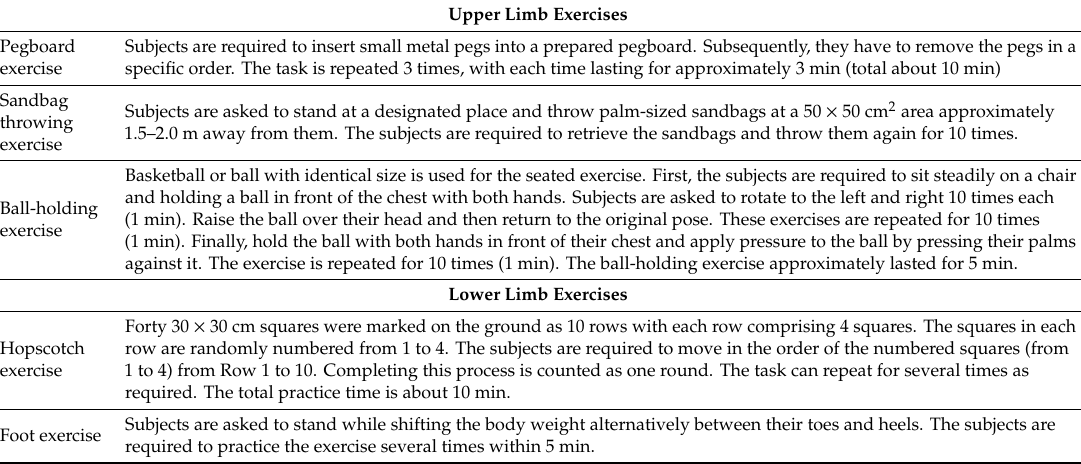
Table 3. Structured Limbs